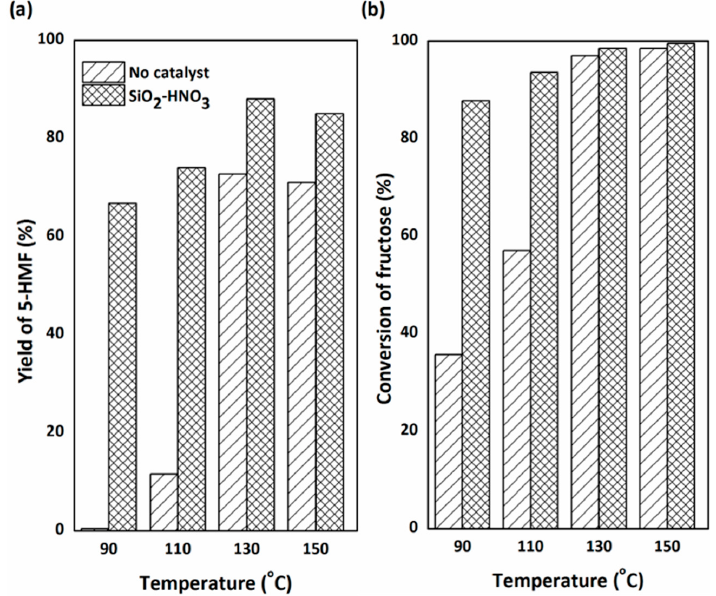
Figure 6. Effect of SiO 2 ‐ HNO 3 on fructose dehydration in DMSO at different temperatures. ( a ) Yield of 5 ‐ HMF, ( b ) Conversion of fructose. Reaction conditions: 1.37 mmol fructose without catalyst or with 50 mg SiO 2 ‐ HNO 3 in 4.0 mL DMSO after 1 h.